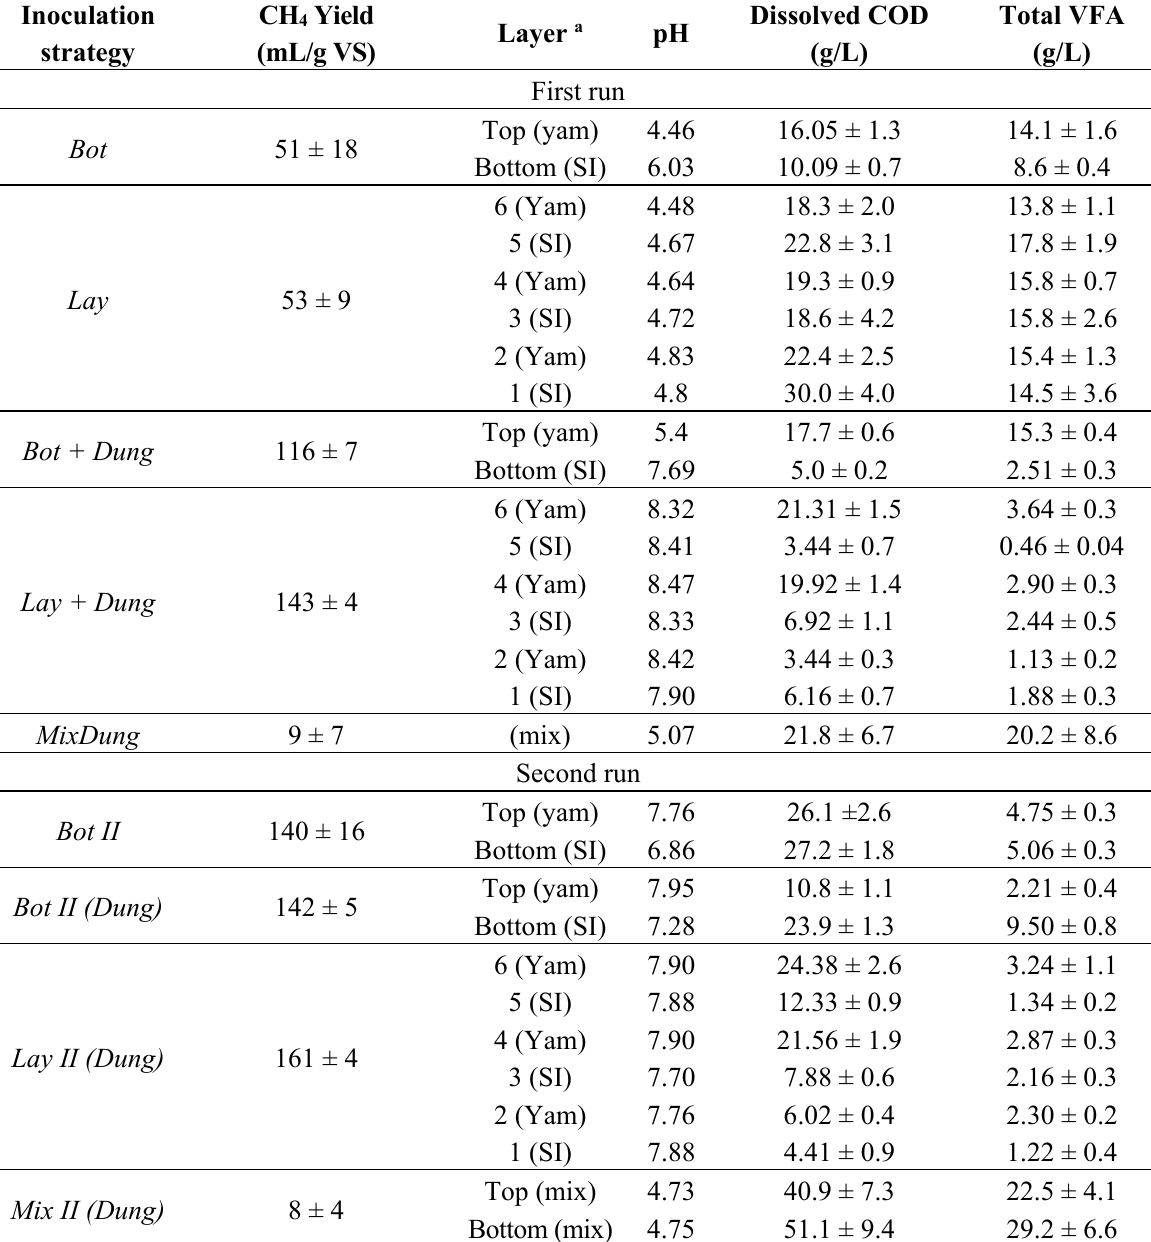
Table 3. Accumulative methane yields and chemical analysis of layers in the batch